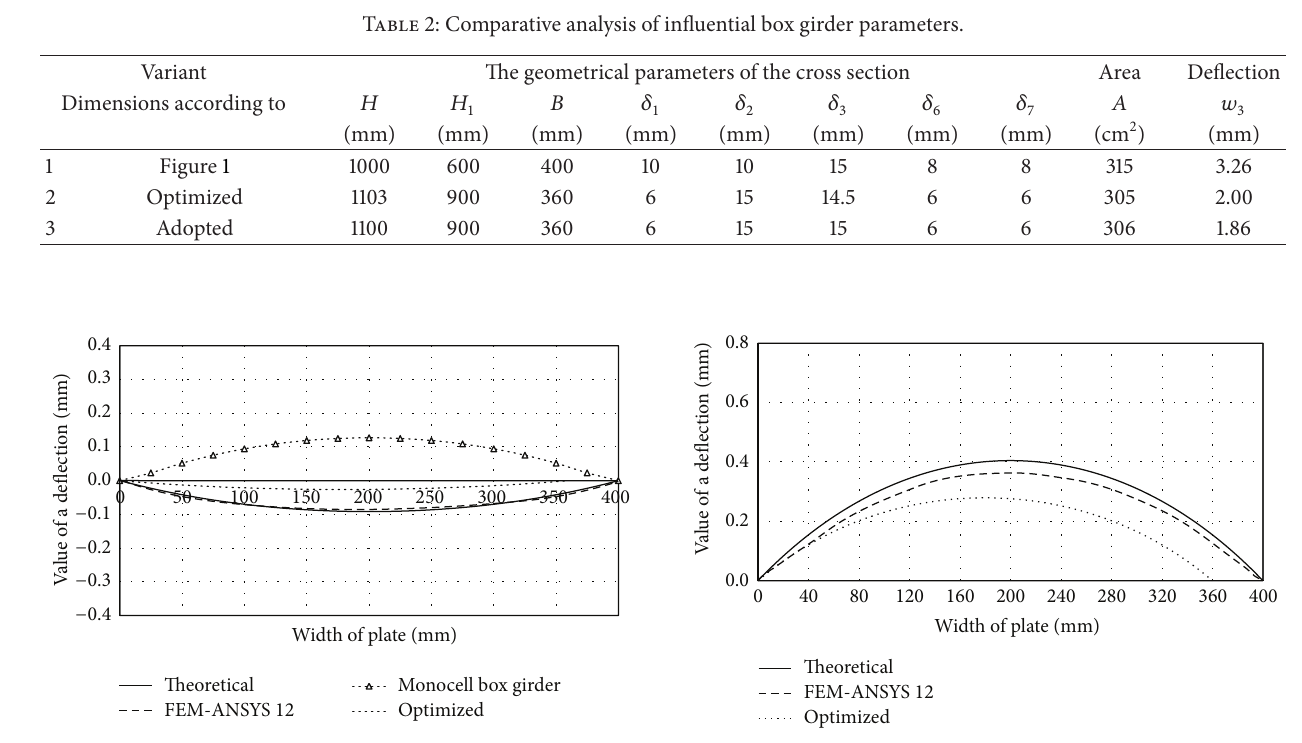
Figure 7: Comparative diagram of deflection of middle